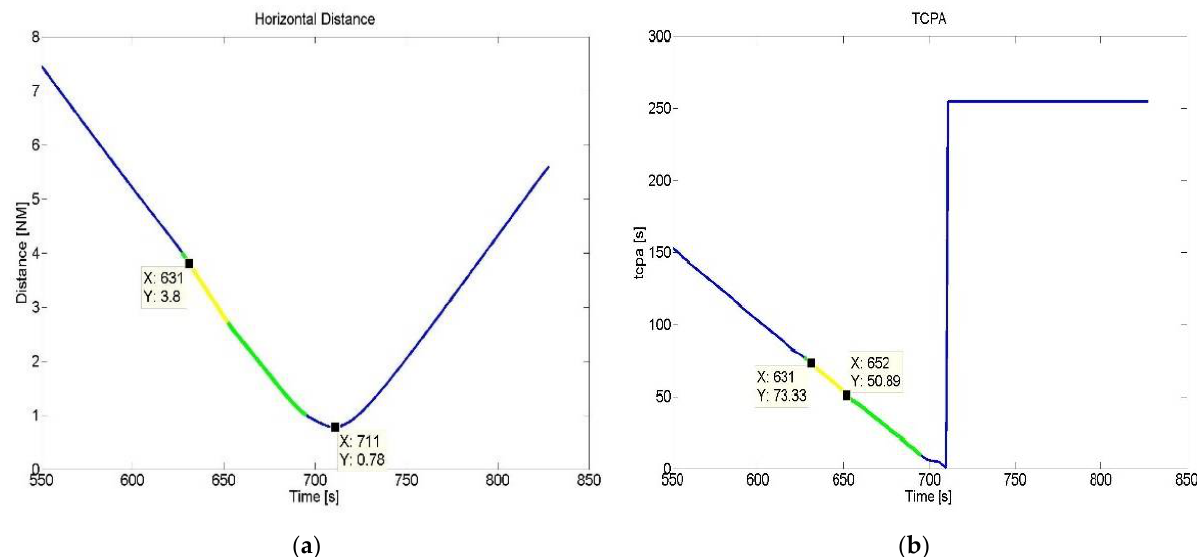
Figure 21. ( a ) Relative distance between the RPAS and the head-on intruder during the encounter of Figure 16. The Caution alert activates at 3.8 NM, while the RWC maneuver is executed at about 2.8 NM, determining a minimum distance of about 0.8 NM that is outside the Well Clear volume. ( b ) Time to closest point of approach during the encounter. The Caution alert activates at 73 s of t CPA, giving to the RP the time to evaluate the conflict, select the RWC maneuver, and execute it at about 55 s of t CPA, avoiding the LoWC.